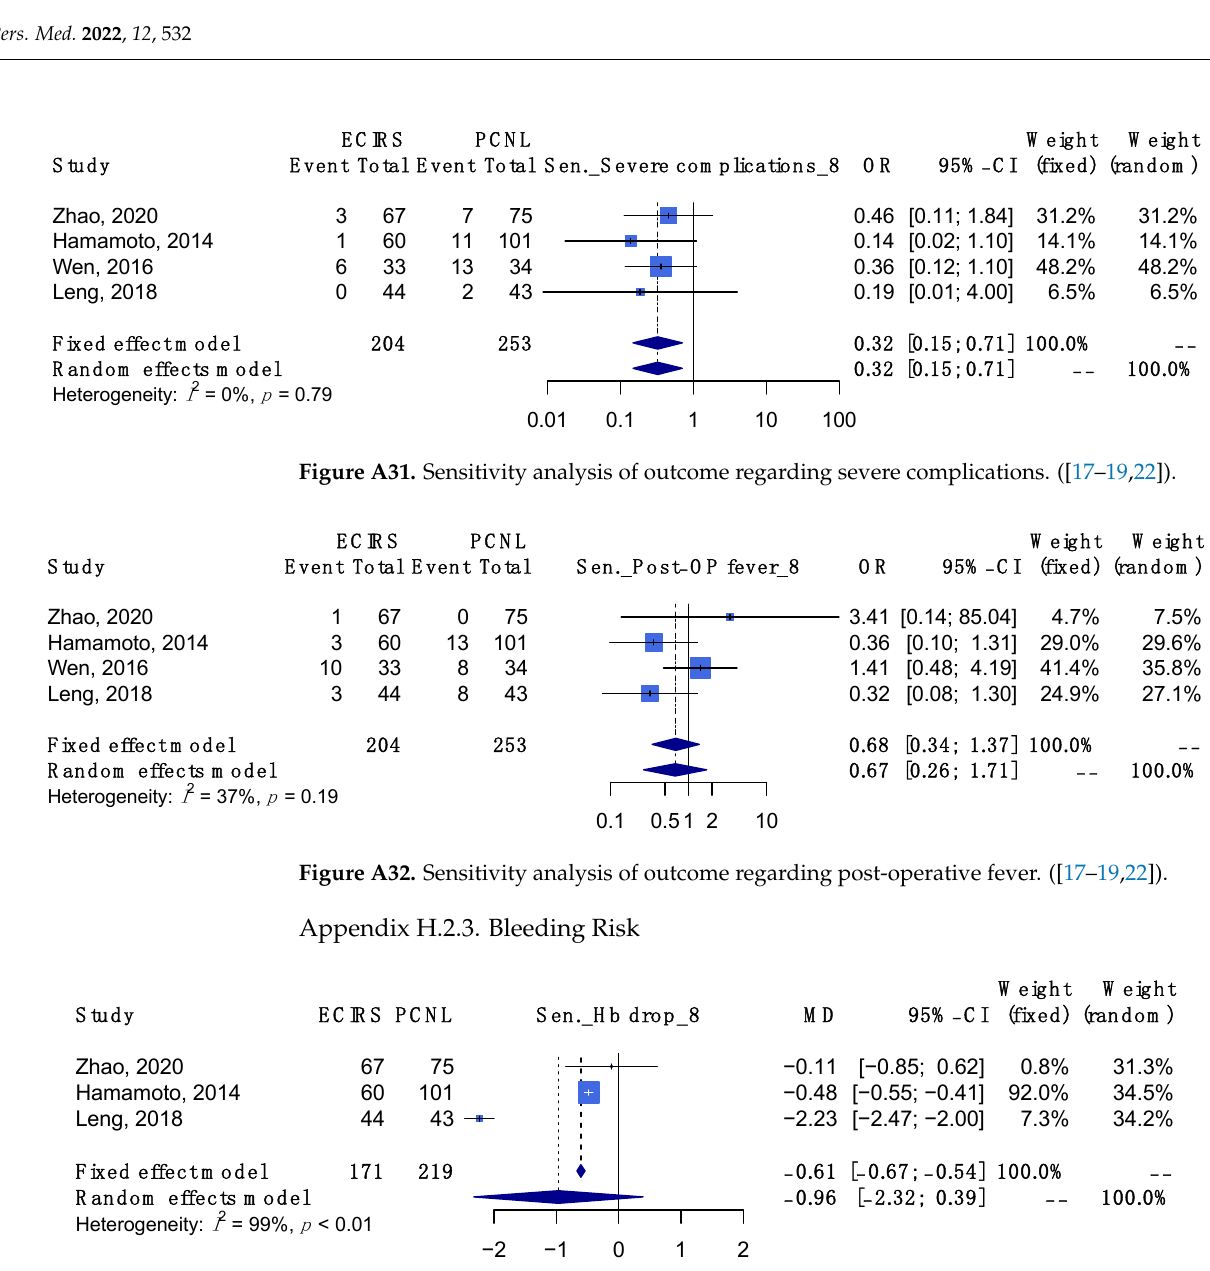
Figure A30. Sensitivity analysis of outcome regarding overall complications. ([17–19,22])